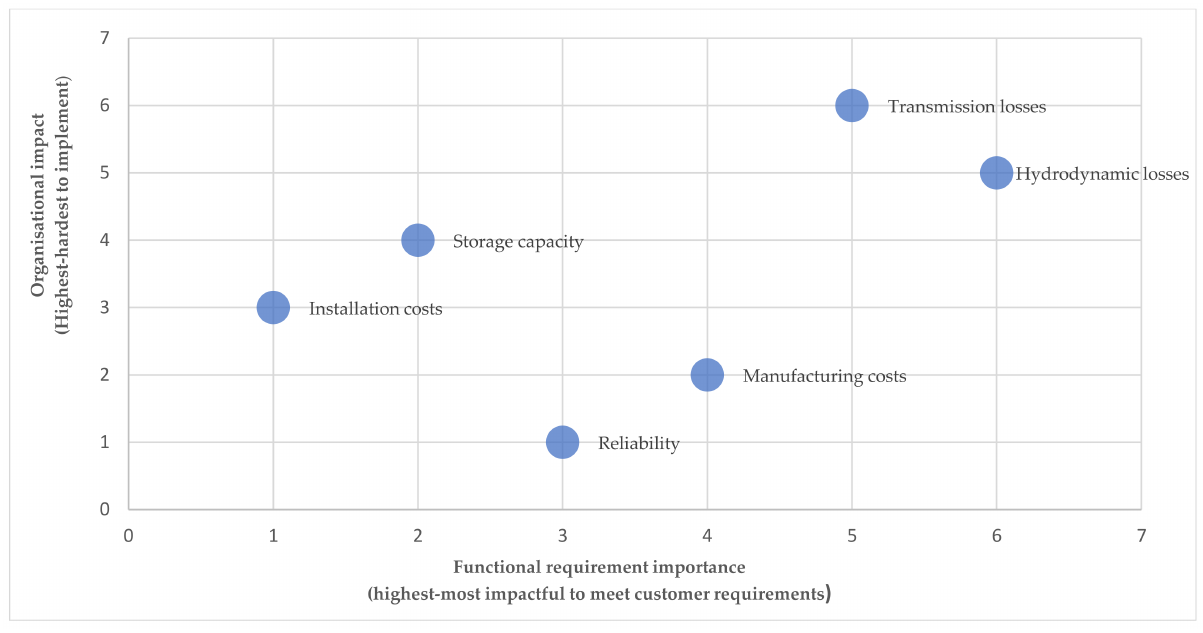
Figure 4. Example highlighting functional requirements with respective overall impacts and organisational capabilities. Those further to the right are more impactful to meet customer requirements, and those closest to the bottom are easiest to